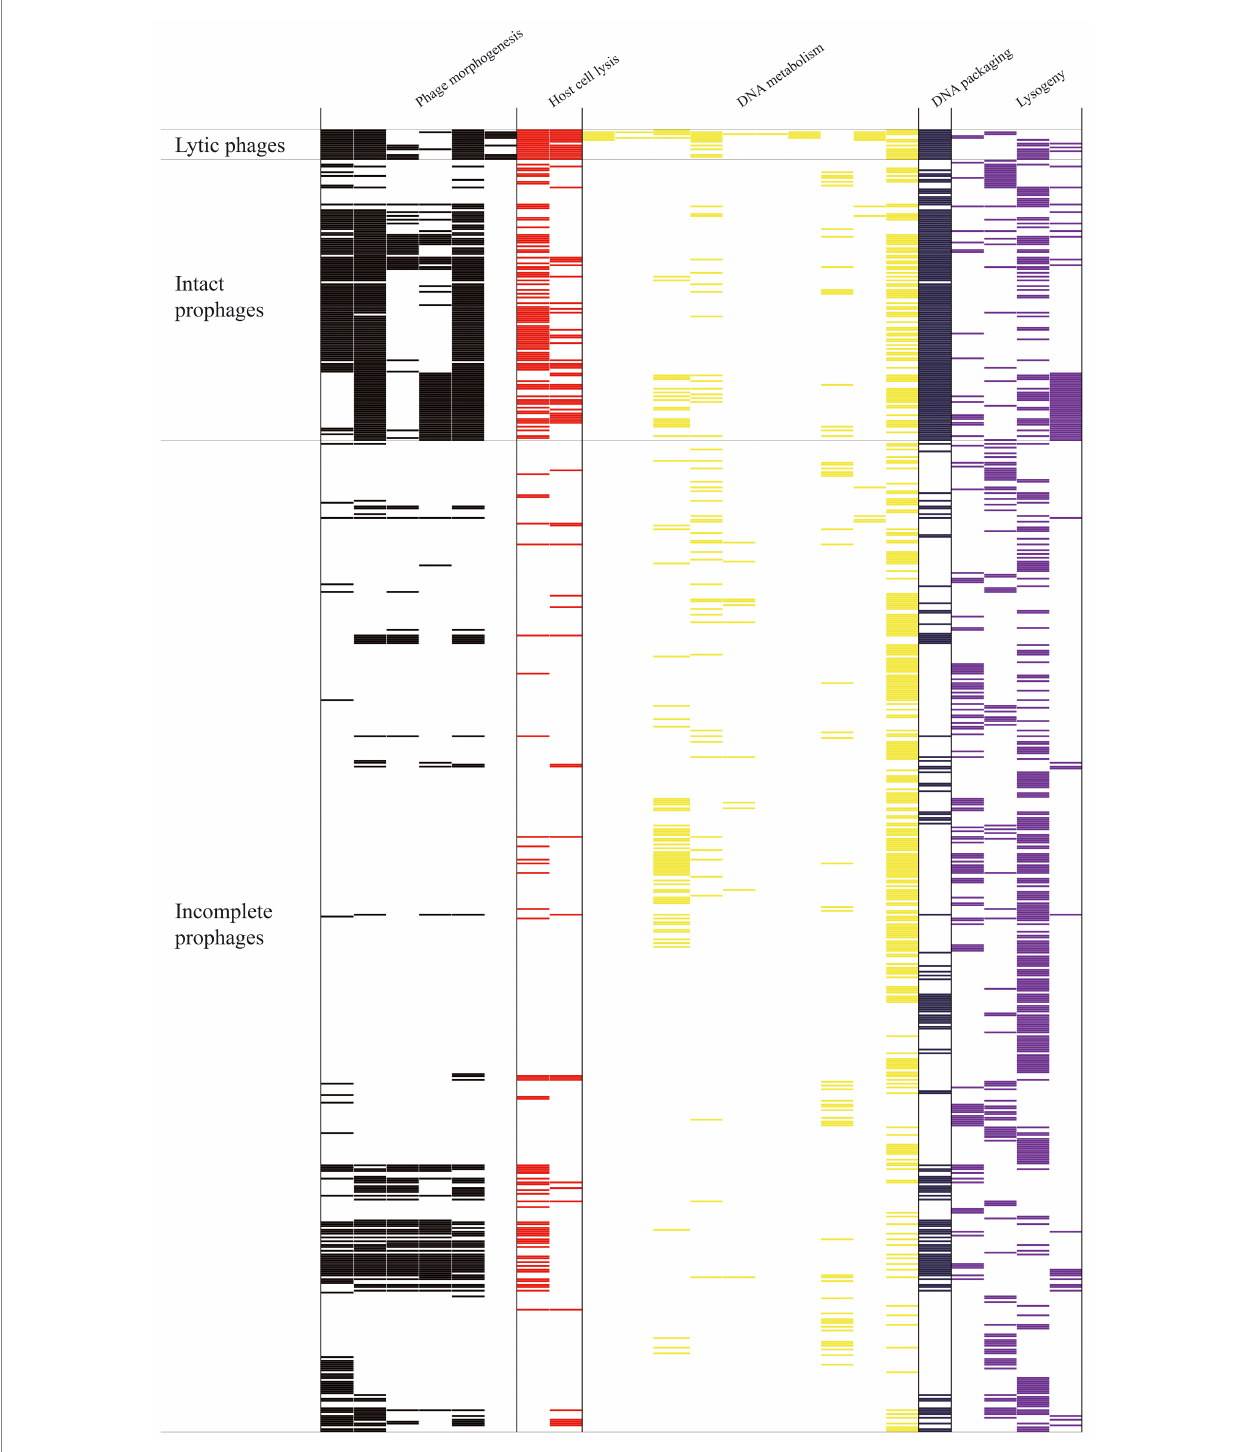
FIGURE 3 Heat map showing gene distribution associated with phage morphogenesis, host cell lysis, DNA metabolism, DNA packaging, and lysogeny of S. aureus 148 intact prophages, 522 incomplete prophages, and 16 lytic phages. Gene presence (colored blocks) or absence (white) is